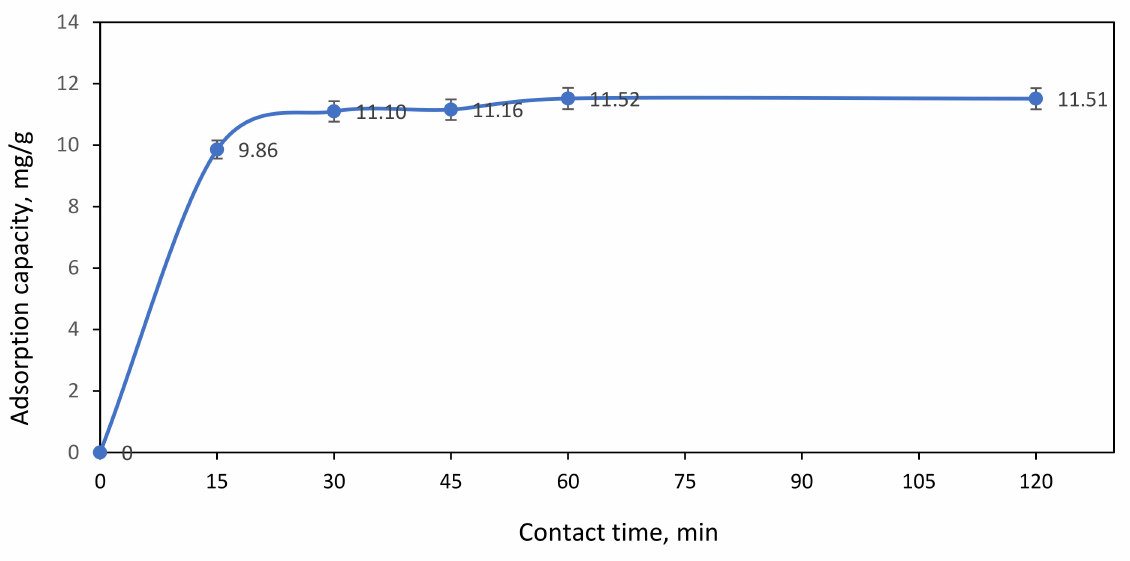
Figure 10. Effect of contact time on adsorption capacity of Ni(II) ions. Condition: [Ni(II)] = 100 ppm, dosage of adsorbent = 50 mg, pH =